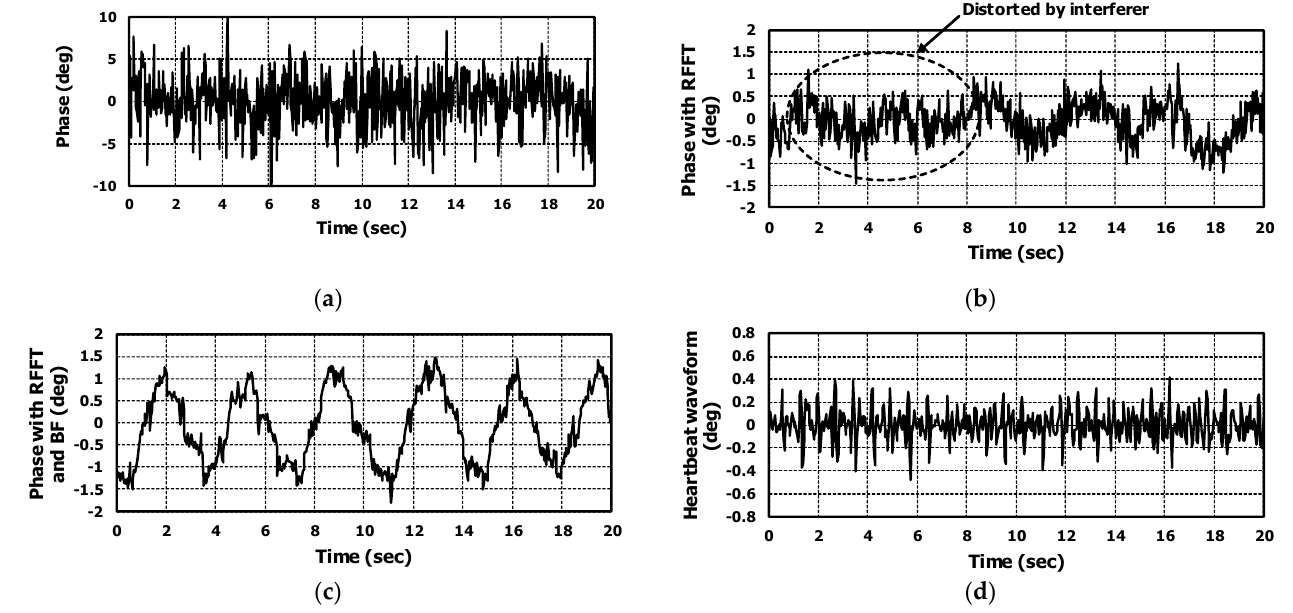
Figure 13. For the case with interferer, the extracted phase signal from measured raw data of radar. ( a ) is raw phase signal, ( b ) is the phase signal applying range-FFT, ( c ) is the phase signal applying range-FFT and beamforming, and ( d ) is the extracted heartbeat waveform from the ( c ).